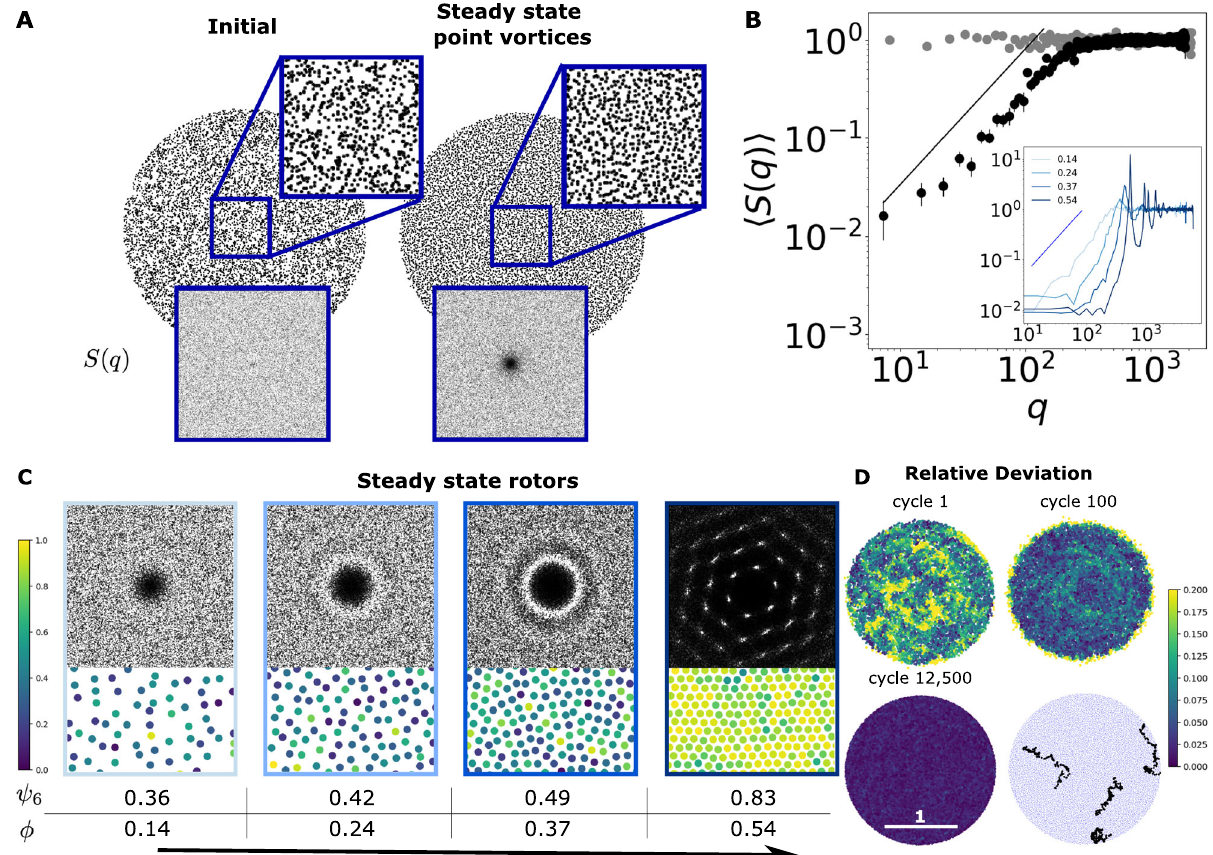
Fig. 3 Hyperuniformity in ensembles of point vortices and rotors. A Snapshots of 10,000 point vortices initially (left) and at steady state (right). Insets show the structure factor, S ( q ) with a distinct cavity at steady state. B Angular average of the structure factor shown in ( A ), in a log-log scale with solid line showing a q 1.3 scaling. Error bars are standard deviation over ten well-separated timesteps. Inset shows the structure factor of the rotors shown in ( C ) with increasing hue corresponding to increased concentration ϕ = (0.14, 0.24, 0.37, 0.54). Solid line is the same α ~ 1.3 scaling. C Steady-state con fi gurations of 2000 membrane rotors with the corresponding structure factors, showing a transition from disordered hyperuniformity to a hexagonal lattice. Particles ¼ ∑ e 6 i θ ij , with the sum taken over nearest neighbors as found by a are colored according to their local bond orientation parameter ψ 6 . For particle j , ψ j i 6 Voronoi diagram. The table gives ensemble-averaged values, N (cid:3) 1 ∑ j ψ j . D A plot of the relative deviation for each particle, with the relative deviation of 6 particle i de fi ned by how far it is displaced from its position at the previous cycle, i.e., ∣ r i ( t + t cyc ) − r i ( t ) ∣ . The cycle time is calculated at steady state as the average time it takes the system to rotate by 2 π . Particles are colored by their relative deviation, from blue to yellow with increasing deviation. The plot at the bottom shows the strobed position of four particles during a time interval of Δ t ≈ 115 cycles; the particles in the strobed frame move along Brownian- like